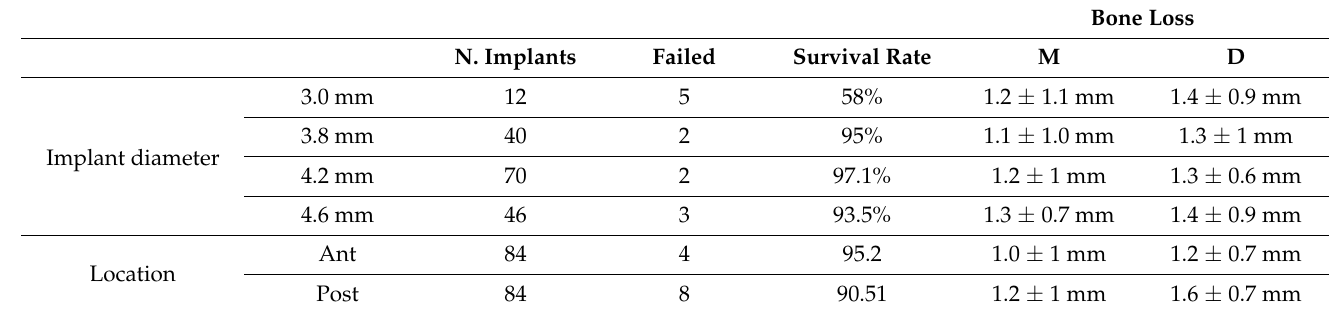
Table 2. Implant survival rate and Marginal Bone Loss (MBL) at 48 months.